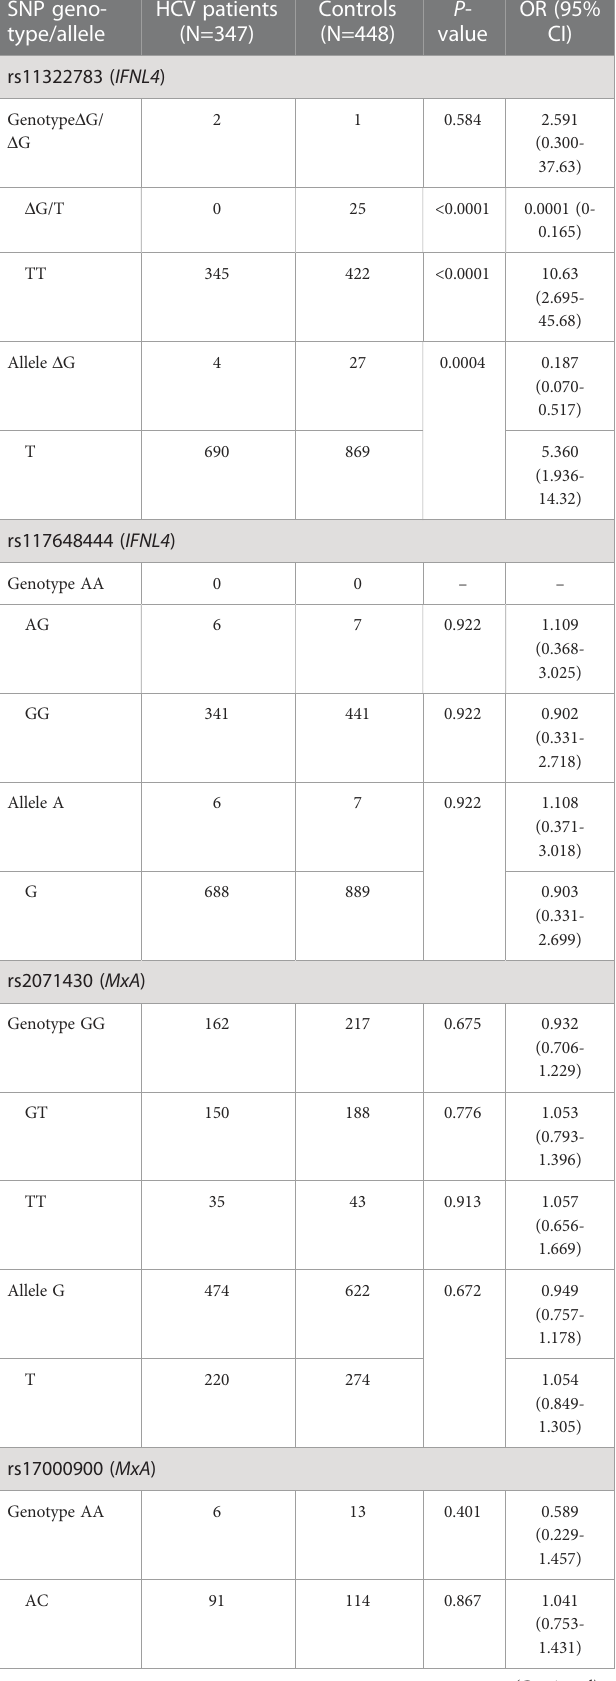
TABLE 1 Frequencies of SNPs in the IFNL4 , MxA , and MxB gene in Yunnan HCV patients and controls. SNP geno-